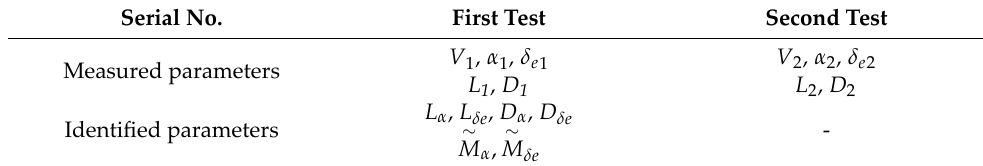
Table 3. Parameters for the velocity derivatives’ solution. Serial